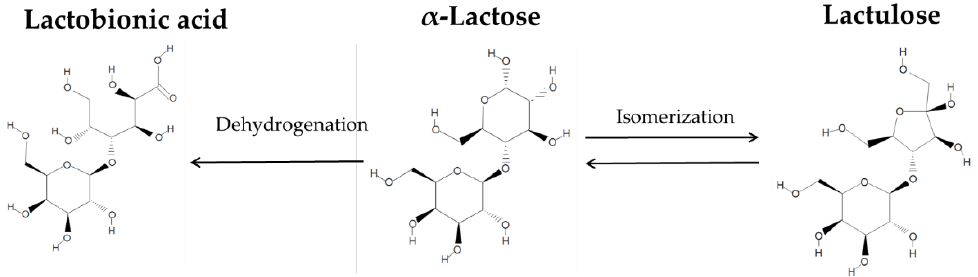
Figure 1. Reaction pathway for the formation of lactulose and lactobionic acid via isomerization and dehydrogenation, respectively.